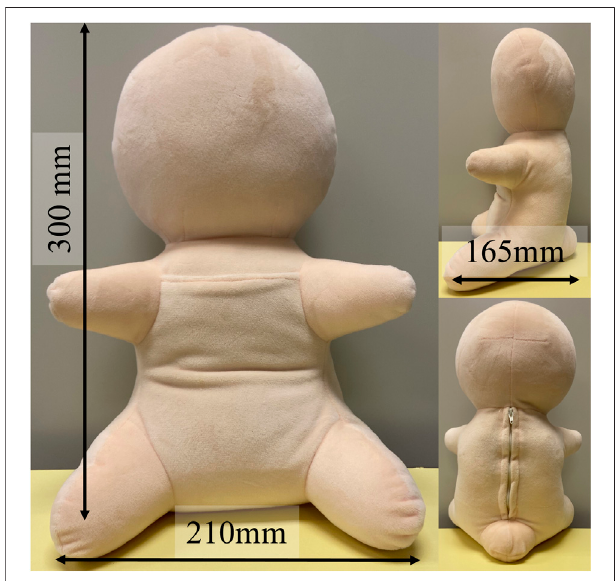
FIGURE 1 | Minimal design of a human infant for interactive doll therapy,